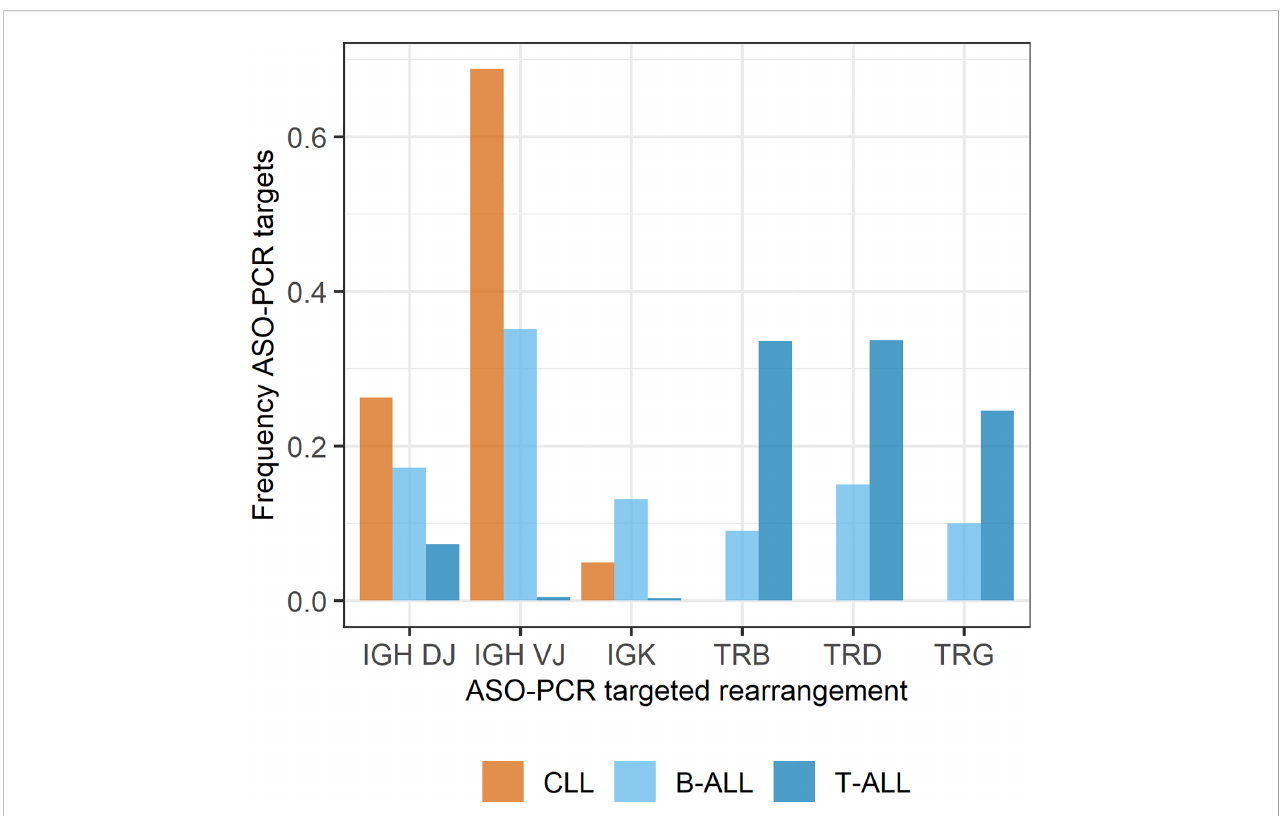
FIGURE 1 Frequency of IG and TR rearrangements as ASO-PCR targets in actively used MRD assays of patients with CLL (N=520), B-ALL (N=1078), and T-ALL (N=322). In accordance with the literature (21), 23% of the ALL patients in our assessment had a T-ALL diagnosis and 77% were diagnosed with B-ALL. For 88% of the patients two MRD assays are established, and ~10% of patients have only one assay for MRD assessment in both ALL sub-entities, thereby allowing assessments on the distribution of ASO-PCR targets from 520, 2110, and 614 assays for CLL, B-ALL and T-ALL,